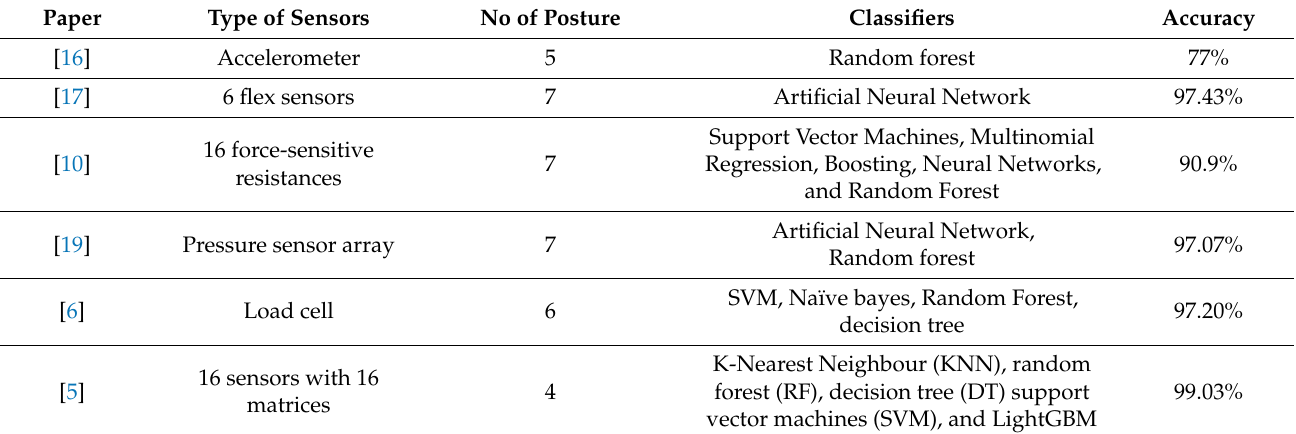
Table 1. Literature review